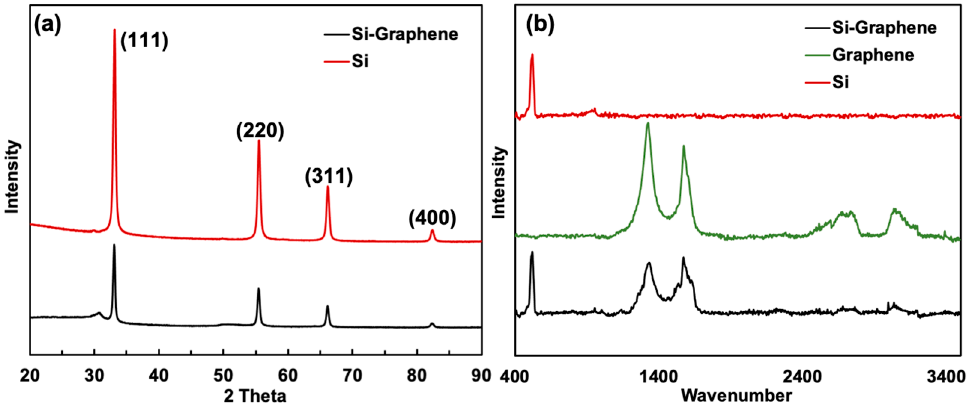
Figure 4. ( a ) XRD patterns of Si nanoparticle and Si-graphene composite; ( b ) Raman spectra of Si, graphene and Si-graphene composite.